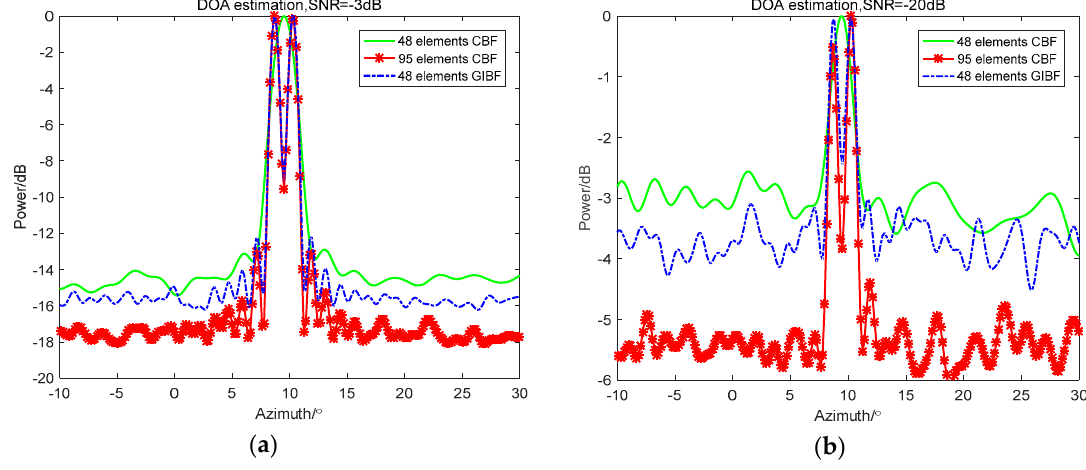
Figure 4. Comparison between CBF and GIBF under different SNRs (signal-to-noise ratio): ( a ) − 3 dB; ( b ) − 20 dB.